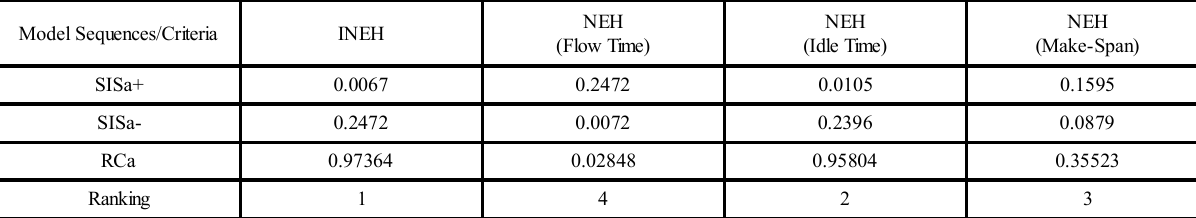
NEH NEH NEH (Flow Time) (Idle Time) (Make-Span)